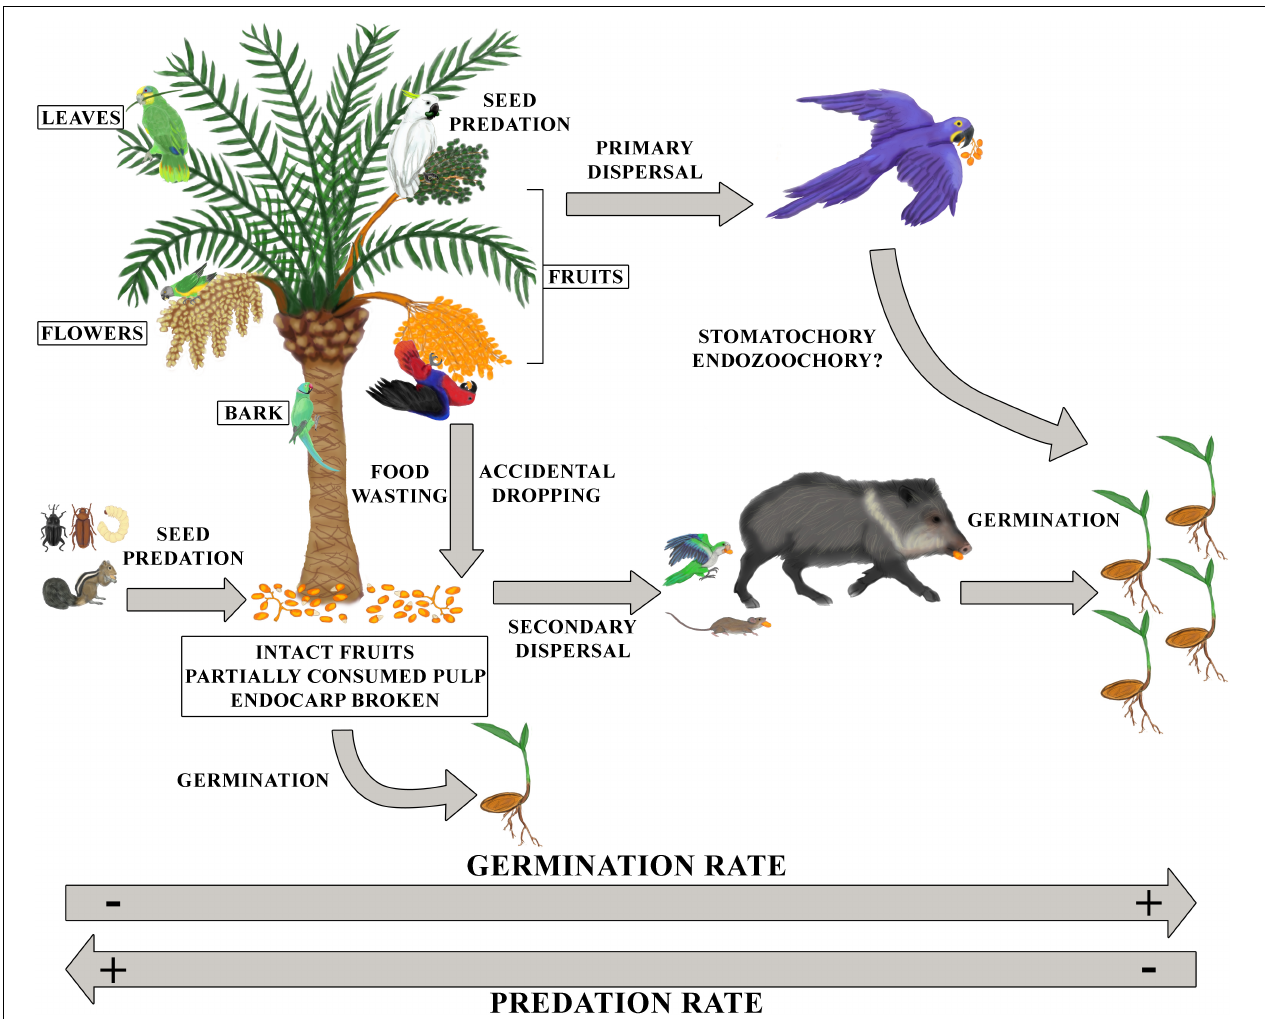
FIGURE 7 | Although most known interactions between parrots and palms have been seed predation and consumption of vegetative parts such as leaves or bark (antagonistic interactions), parrots can also feed using strategies that favor palms (mutualistic interactions). When parrots consume only the pulp of the fruits (defleshing), without consuming the seeds or leaving some undamaged and viable, they can favor the germination of seeds that fall to the ground accidentally or when the individual wastes them (food wasting). In many cases, parrots carry the fruits or seed with their feet or beaks to consume them on perches, dispersing them (stomatochory) and favoring germination in areas far from the mother plant, where predation rates are lower. In addition, these fruits and seeds that fall to the ground, either under the mother palm or under a perch, may then be secondarily dispersed by other species. Although it is possible that parrots also swallow palm fruits and disperse them by endozoochory, this dispersal mechanism has not been described for parrots and palms. Finally, parrots may also consume palm flowers, possibly contributing to pollination. Illustrations by Dailos